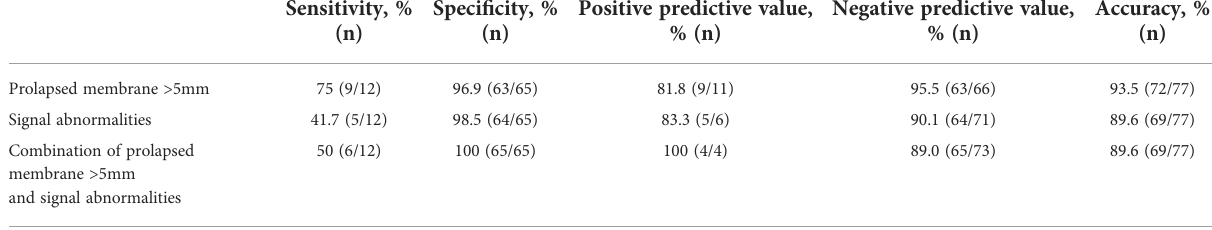
TABLE 3 Ability of MRI-detected FM defects to predict PROM*.